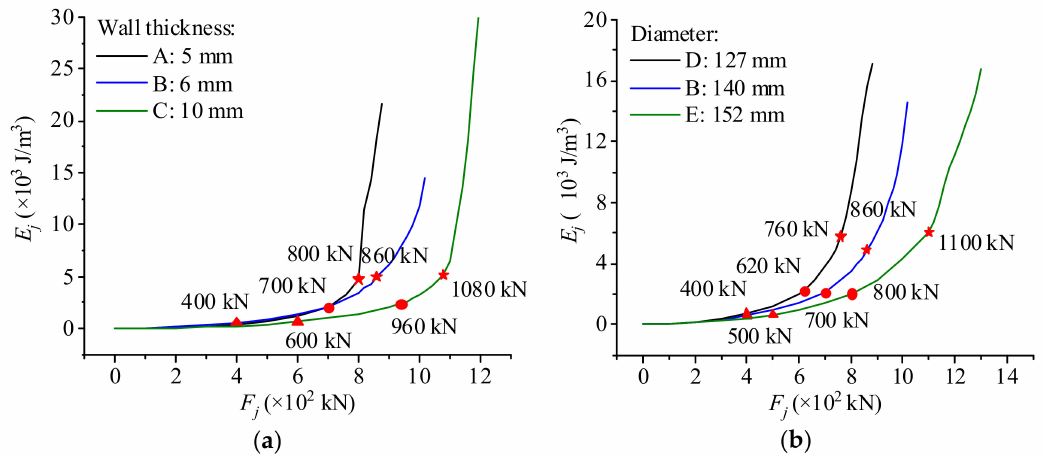
Figure 10. The E j -F j curves of the di ff erent supports: ( a ) The E j -F j curves of the supports with di ff erent wall thickness; ( b ) The E j -F j curves of the supports with di ff erent